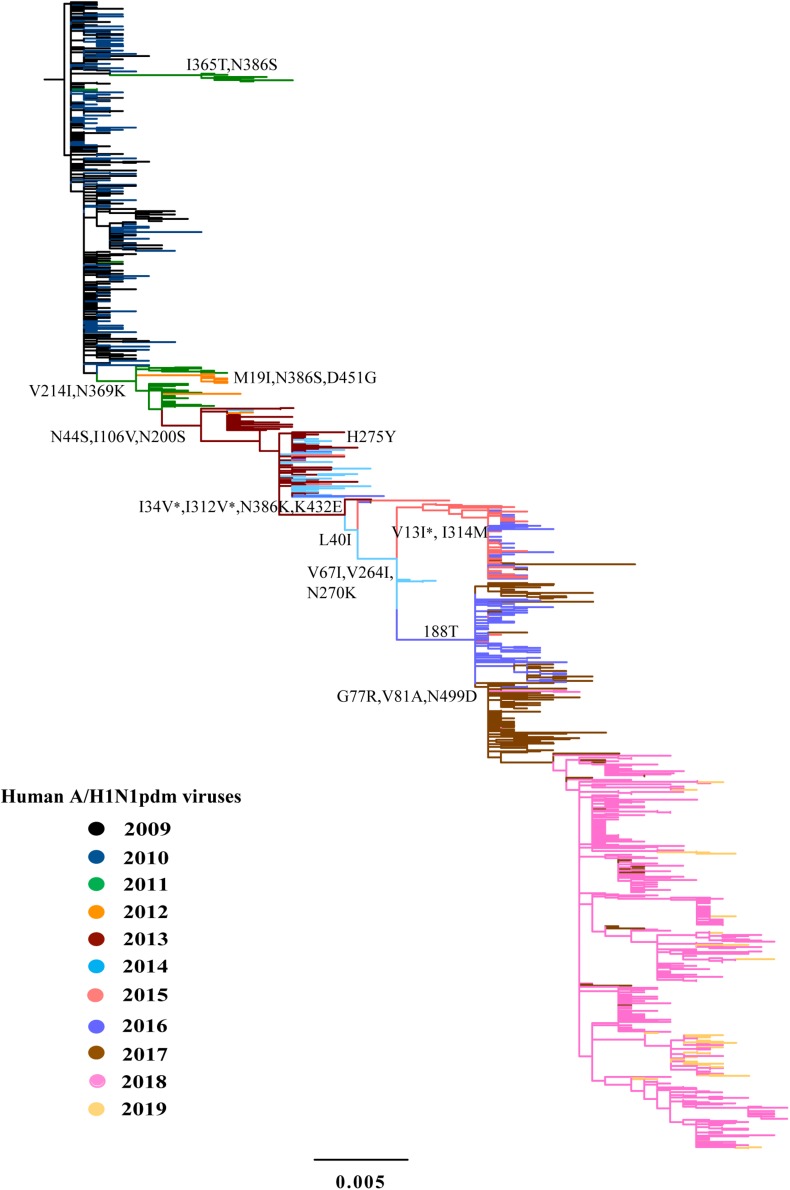
Phylogeny of A/H1N1pdm virus by NA gene. The ML tree inferred from 1043 A/H1N1pdm virus NA sequences in China from 2009 to 2019. The color of the branch is marked by the isolation year of the strain. Fixed amino acid mutations are mapped at the major nodes of the tree. Positively selected sites are highlighted by asterisks (*).